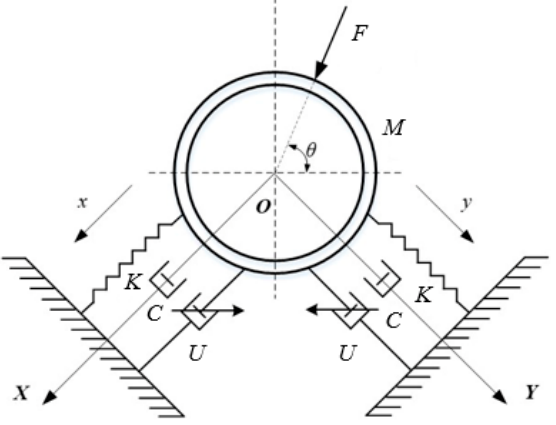
Figure 5. Mechanical model of semi ‐ active vibration control system.